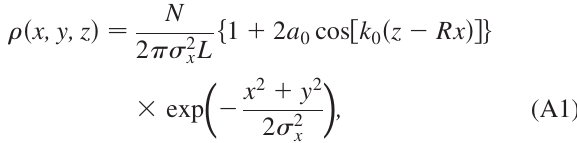
FIG. 17. (Color) FEL intensity at 1.5 A˚ measured on a down- stream YAG screen vs LH energy when all 33 undulator sections are